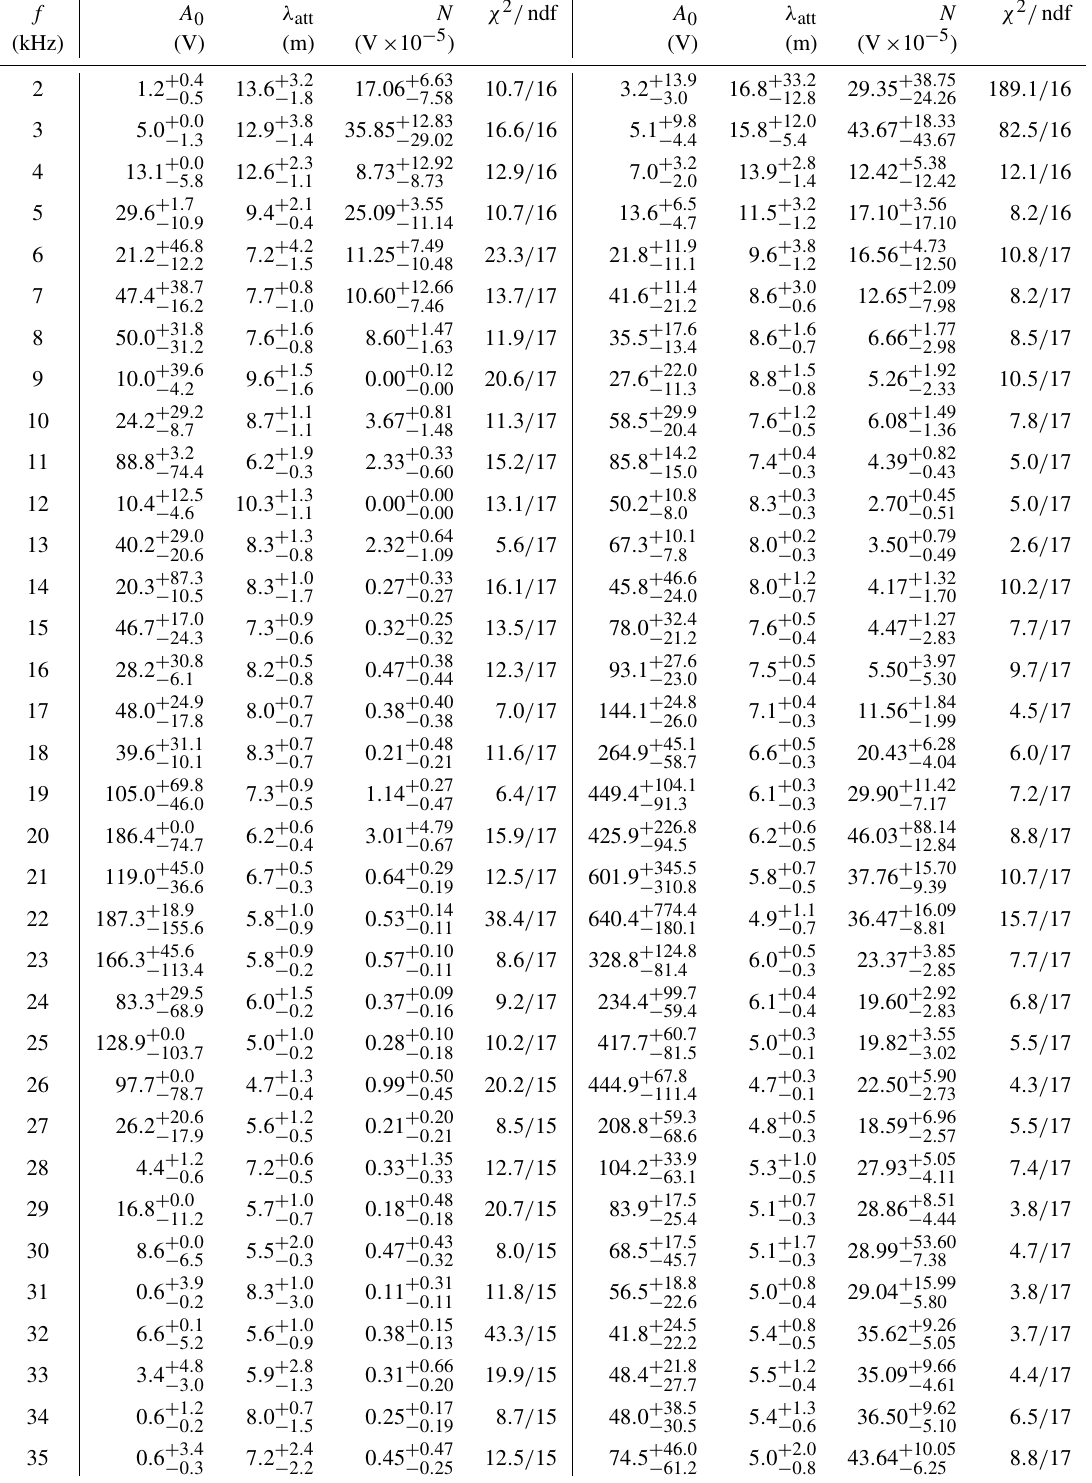
Table 5. Results of the fitting for all frequencies. Left values for sine signals, right for chirps.